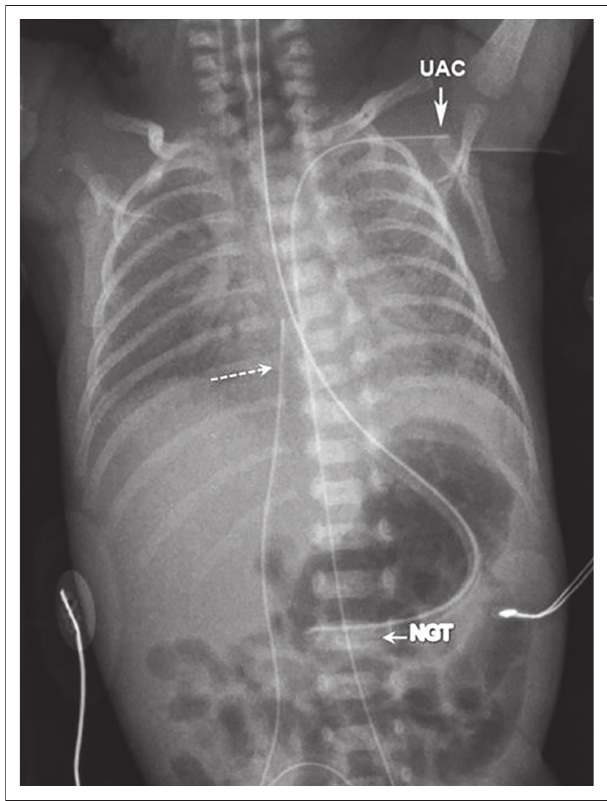
FIGURE 7: The umbilical arterial catheter (UAC) has been advanced too far. Its distal tip is in the left subclavian artery. The umbilical venous catheter (UVC) tip (dotted arrow) is located in the RA. The end of the nasogastric tube (NGT) is in the